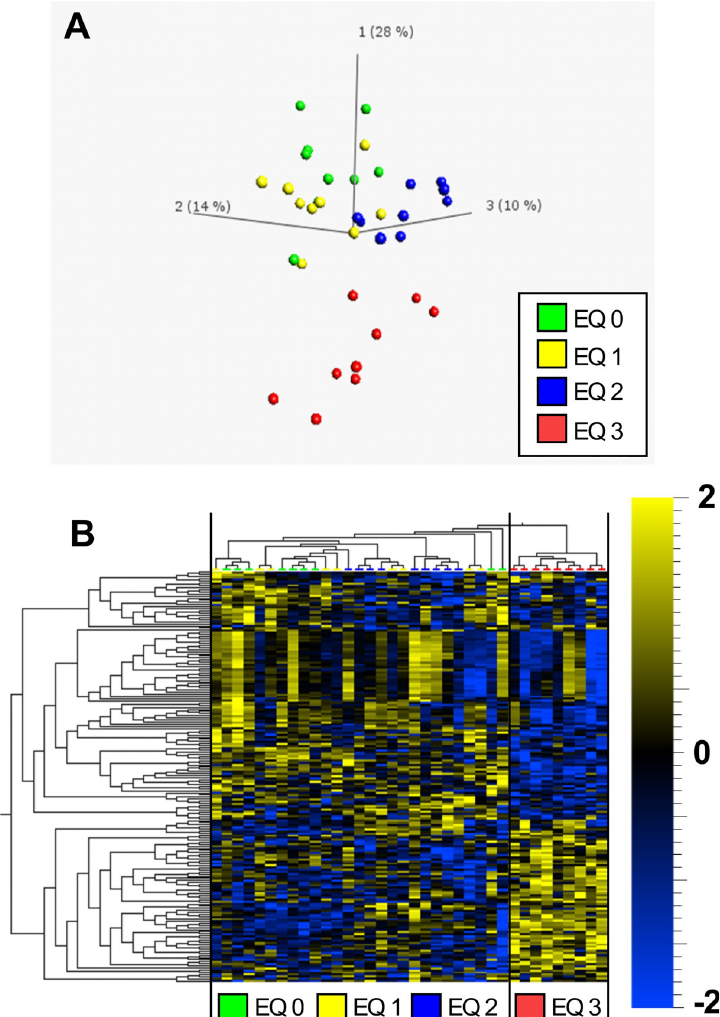
Fig 1. Principal component analysis (PCA) and hierarchical clustering analysis (HCA) of 192 significantly regulated ( p < 0.05, ANOVA) metabolites in livers of Atlantic salmon ( Salmo salar L.) exposed to graded levels of ethoxyquin (EQ) through their diet for 90 days. Differential analysis (ANOVA), PCA (A) and HCA (B) were performed using the Qlucore omics-explorer. The heatmap (B) represents the concentrations of significantly affected metabolites within each measured sample (represented in the columns). Yellow bars indicate higher concentrations of a metabolite, while blue bars indicate lower concentrations of a metabolite, on a scale from -2 to 2, where 1 unit is equal to a variance of 1 from the mean. See S2 Table for a complete overview of individual metabolites. only affected after exposure to EQ 3 (S4 Table). These responses were most notably associated with liver energy metabolism, redox- homeostasis and purine/pyrimidine metabolism. Energy metabolism. The in-depth metabolic screening revealed marked changes in sev- eral pathways related to energy metabolism. Altered metabolite profiles related to hepatic lipid metabolism were characterized by a decrease in diacylglycerol (e.g., palmitoleoyl-oleoyl-glyc- erol (16:1/18:1)) and monoacylglycerol species (e.g., 1-palmitoleoylglycerol (16:1); Fig 2). Also, significantly lower levels of long-chain fatty acids (e.g., stearate (18:0)) and polyunsaturated fatty acids (e.g., omega-3 arachidonate (20:4n3)) were noted. A decrease in carnitine-, and concomitant increase in acetyl-CoA levels suggested increased beta-oxidation rates in livers of fish exposed to EQ 3 compared to EQ 0 (Fig 2).